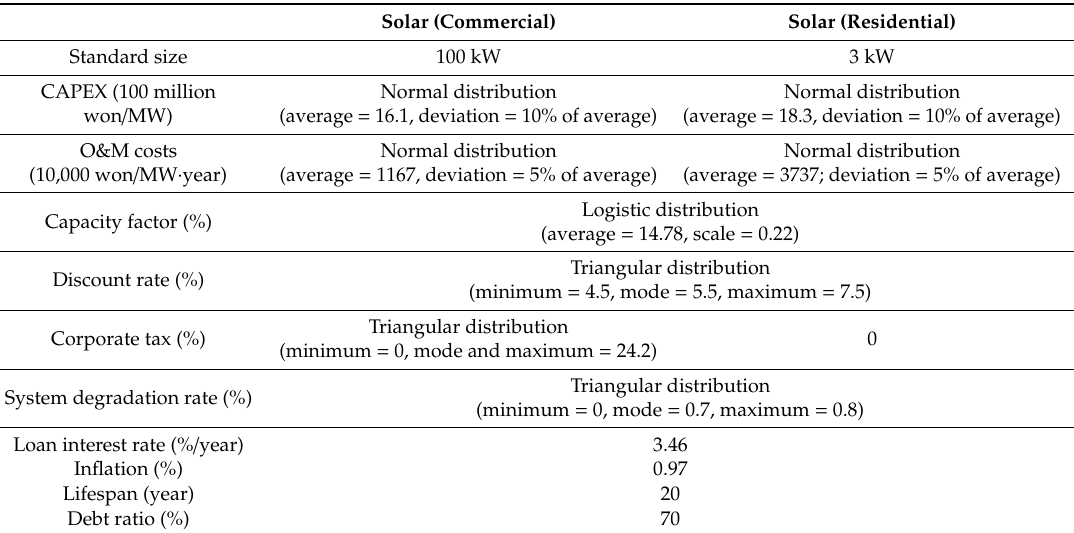
Table 1. Input variables for the solar levelized cost of electricity